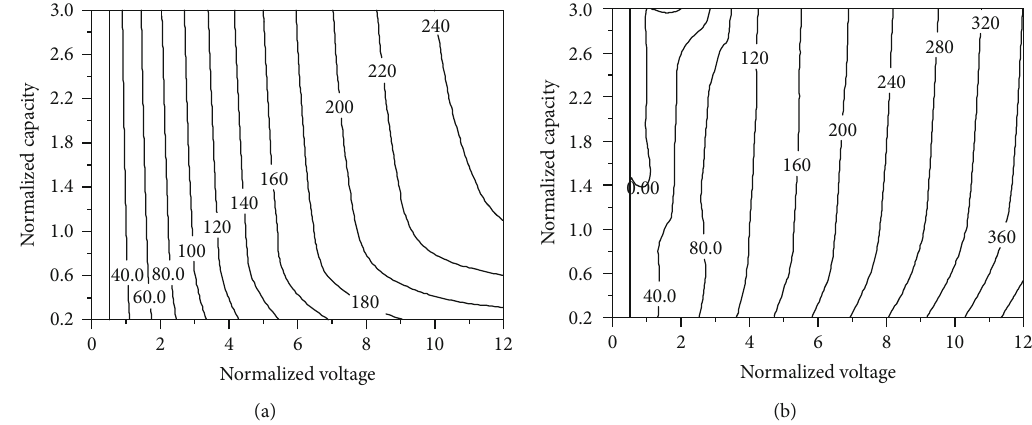
Figure 12: Battery performance for di ff erent battery parameters, and the capacity (W ∙ h) is normalized to 10 × 41 : 9 (W ∙ h): (a) maximum available power; (b) maximum waste power.